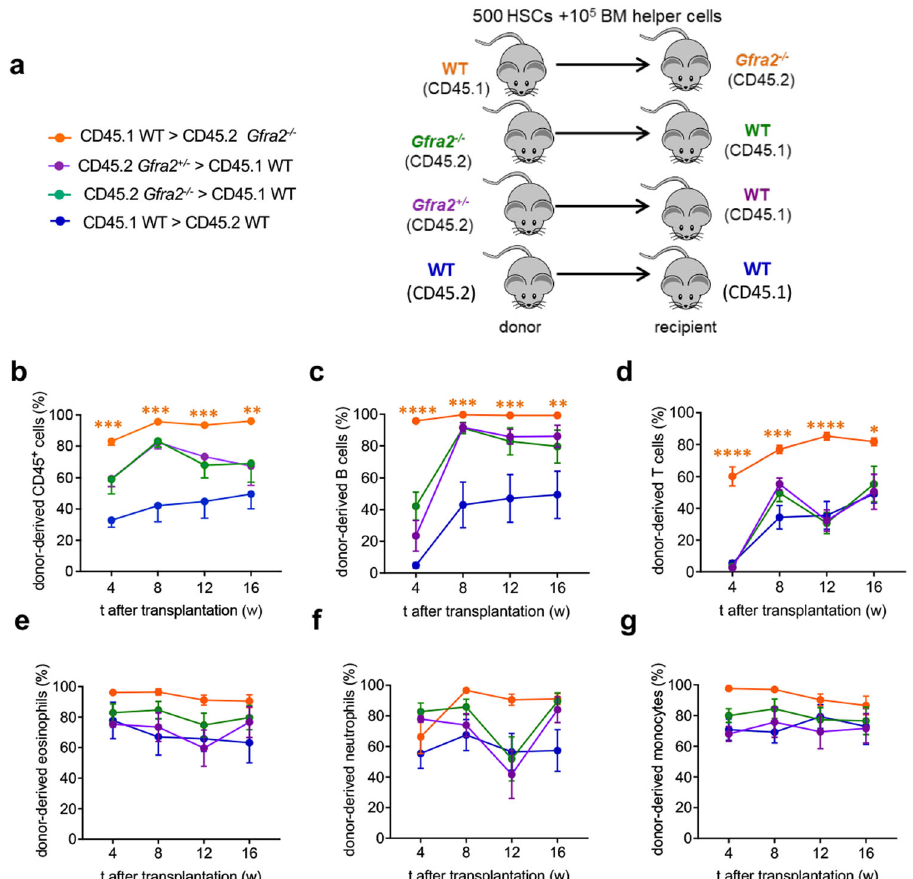
Fig. 4 Cholinergic-de fi cient niche compromises HSC quiescence, leading to increased reconstitution of primary recipients. a Scheme illustrating competitive HSC transplantation in primary recipients. 500 endosteal LSK CD48 − CD150 + HSCs and 10 5 BM helper cells were i.v. injected into lethally irradiated congenic mice of indicated genotype. b – g Donor-derived haematopoietic chimerism ( b ), B cells ( c ), T cells ( d ), eosinophils ( e ), neutrophils ( f ) and monocytes ( g ) at speci fi ed time following primary transplantation of HSCs from donors and recipients of speci fi ed genotypes ( Gfra2 + / − > CD45.1, N = 5; Gfra2 − / − > CD45.1, N = 6; CD45.1 > Gfra2 − / − , N = 4; CD45.1> Gfra2 + / + , N = 4). Data are mean of biological replicates ± SEM. * P <